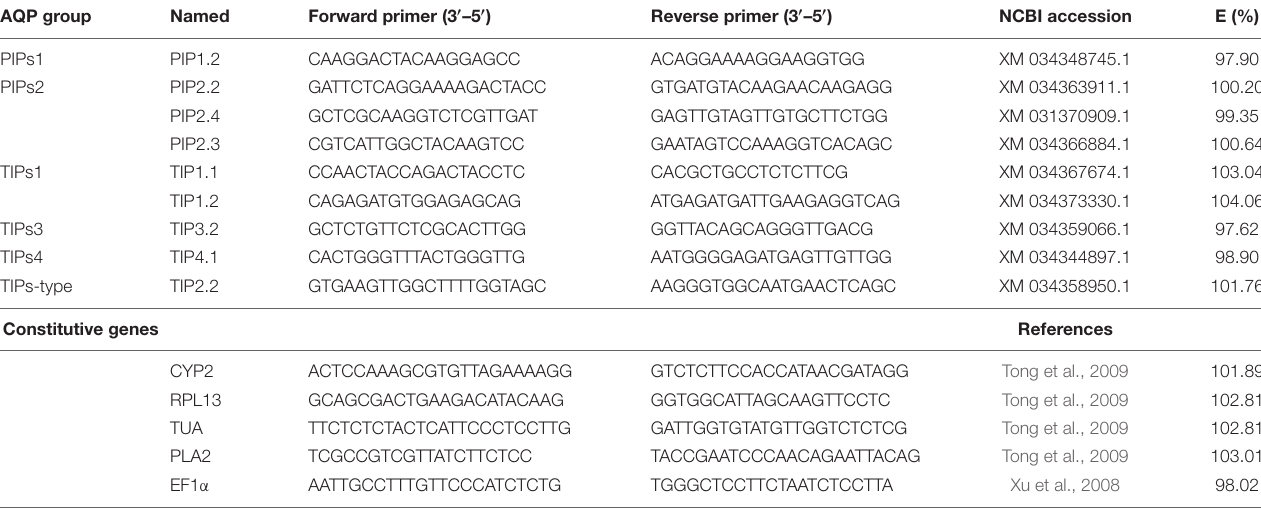
TABLE 1 | Primers were used for the measurement of the selected Prunus dulcis aquaporins (AQPs) expression by real-time qPCR (RT-qPCR). AQP group Named Forward primer (3 (cid:48) –5 (cid:48) ) Reverse primer (3 (cid:48) –5 (cid:48) )